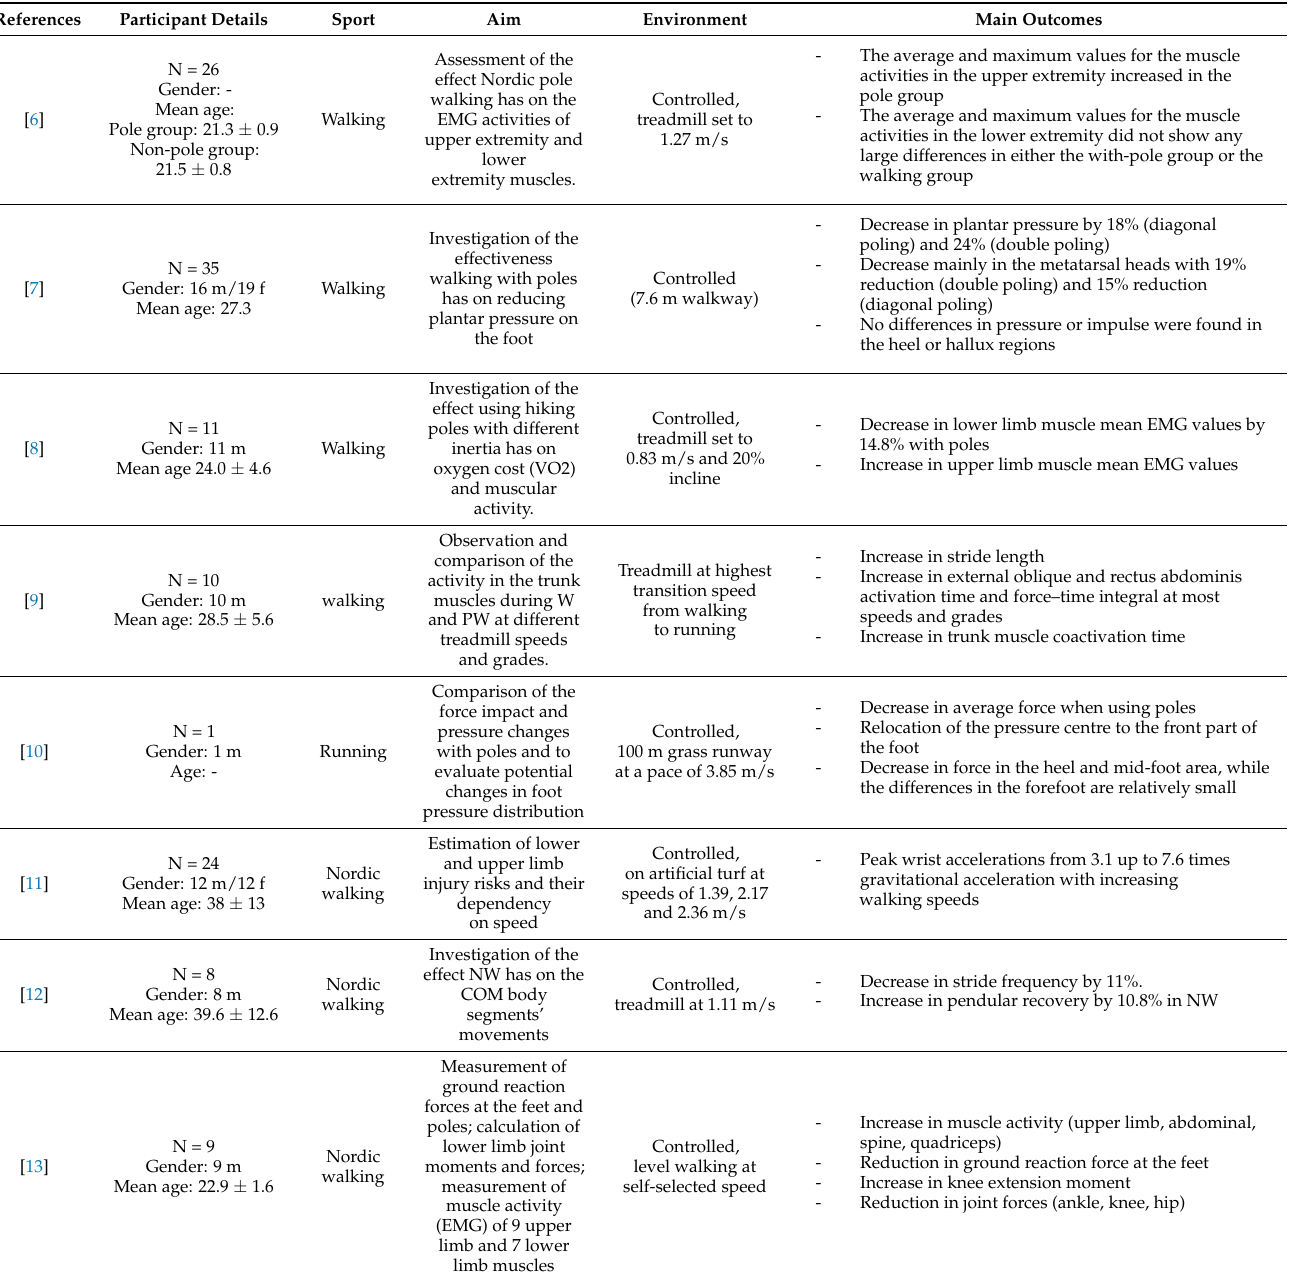
- Reduction in ground reaction force at the feet - Increase in knee extension moment - Reduction in joint forces (ankle, knee,